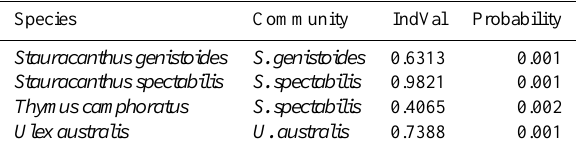
Table 1. Indicator species of each community. The indicator value (IndVal) is maximum when all individuals of a species occur in a single group and in all the sites of that group.